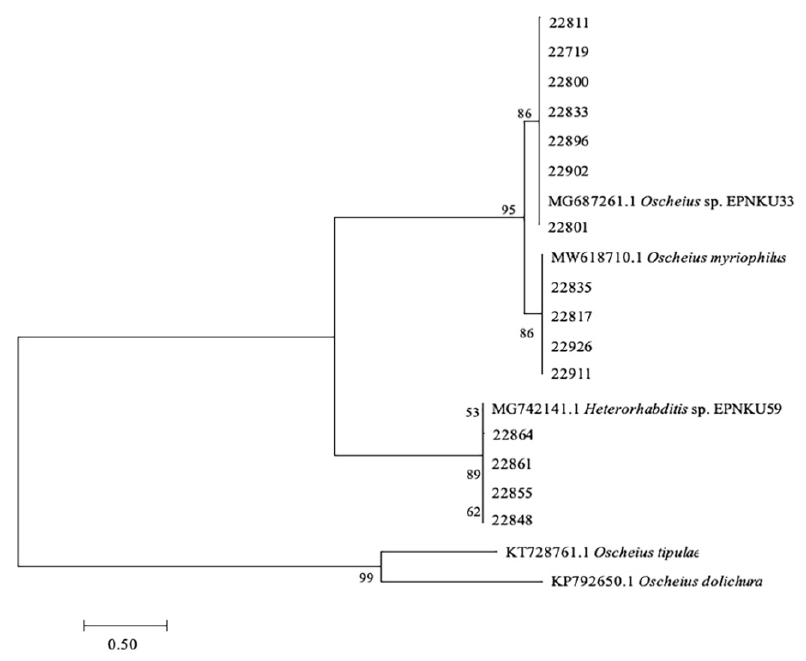
Figure 2. Phylogenetic trees based on ITS rDNA were constructed using neighbor-joining method to describe the Heterorhabditis and Oscheius EPN strains. Numbers on branches represent bootstrap support (>50%) based on 1000 replicates. Scale represents K2P genetic distance.